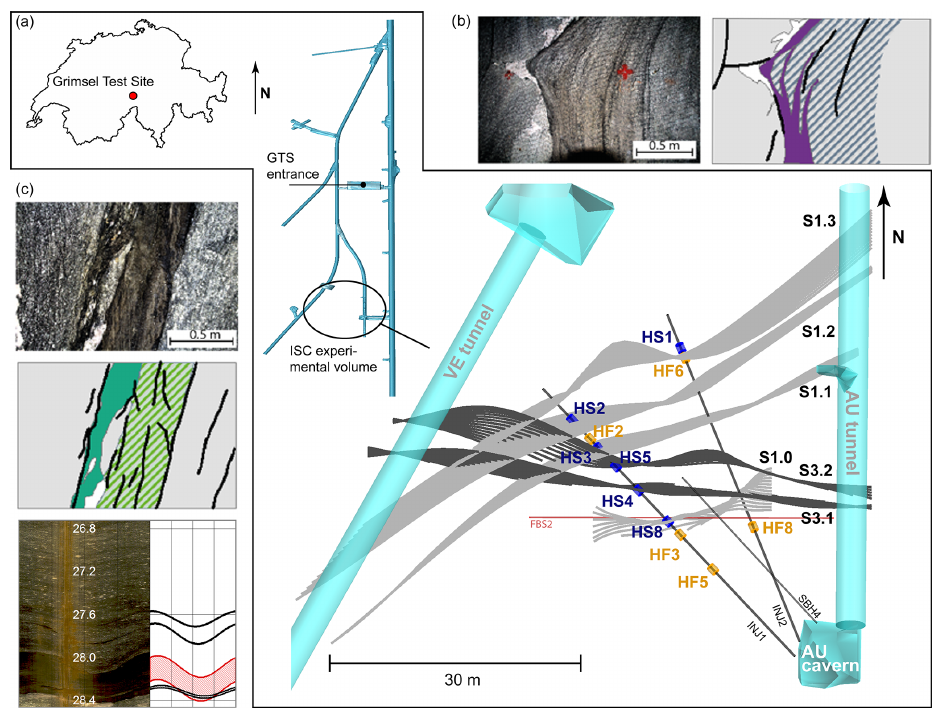
Figure 2. (a) Location of the GTS in Switzerland (source: © https://www.d-maps.com/, last accessed: 23 April 2020) and the location of the ISC experimental volume in the tunnel network operated by Nagra, along with the top view of the ISC experimental volume located between the AU and VE tunnel. The two major shear zones S1 (gray) and S3 (black) intersect the experimental volume and the two injection boreholes (INJ1, INJ2) drilled from the AU cavern. The location of the HS (blue) and HF (orange) injection intervals are shown, as well as the strain-monitoring borehole FBS2 and stress measurement borehole SBH4 used in this study. (b) Shear zone S1 observed in the AU tunnel. (c) Shear zone S3 observed in the AU tunnel along with its observation in the injection interval (red and adjacent fractures in black) of experiment HS4. Panels (b) and (c) were modified after Krietsch et al. (2018a).